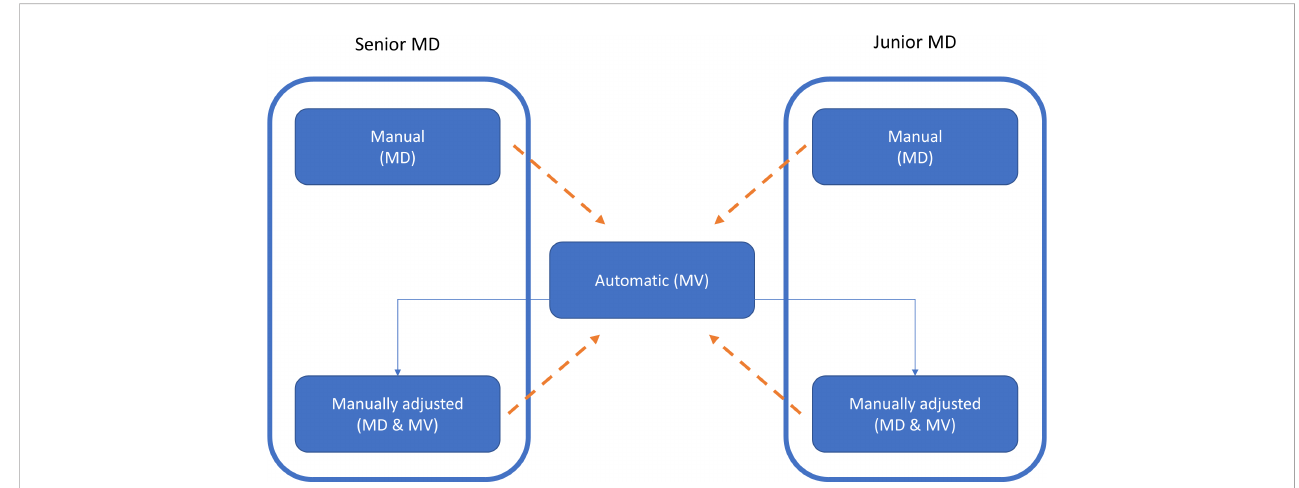
FIGURE 1 The work fl ow of this study for the generation of the VOIs is illustrated by using the box and solid arrows. MD, MV, and MD & MV indicate manual, automatic, and manual adjustment of the automatic delineated VOIs, respectively. The dashed arrows indicate the data comparison versus the MV VOIs for all the investigated metric indexes. A similar comparison was performed using the relative volume (rV) of manually and manually adjusted MV VOIs versus the MV